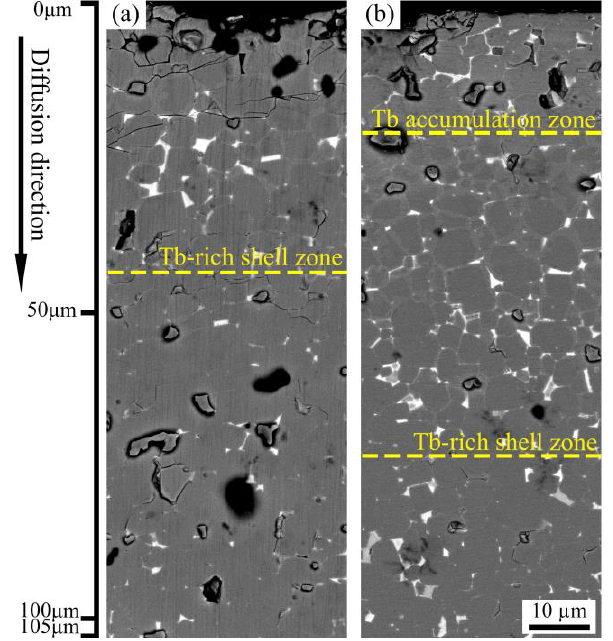
Figure 3. SEM images of section samples (parallel to c-axis) at depth from 0 to 105 μm: ( a ) Tb60 diffusion magnet and ( b ) Tb diffusion magnet.